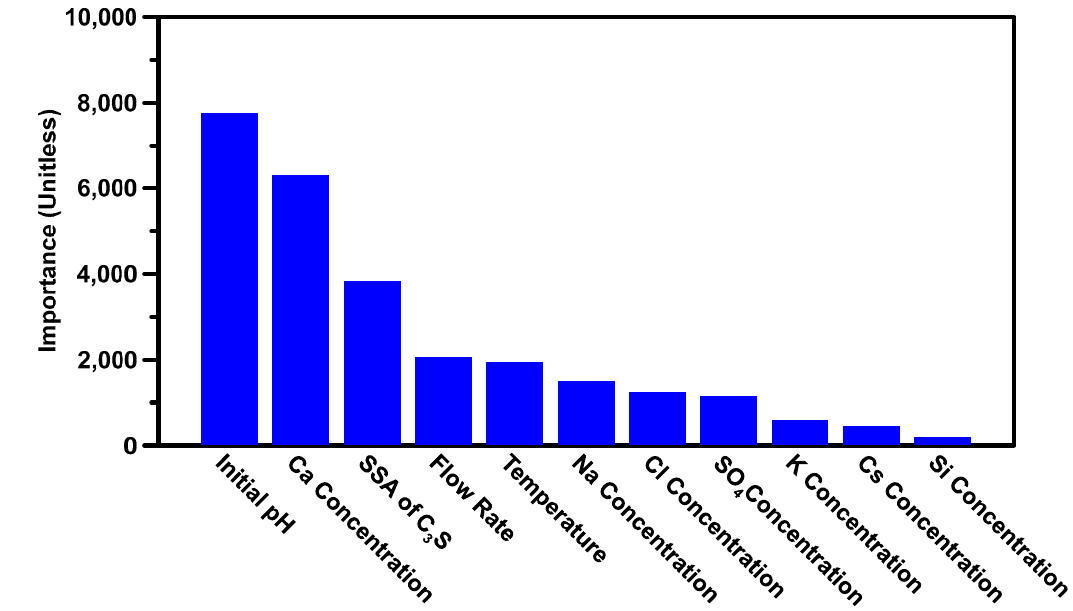
Figure 2. The influence (importance) of input variables based on their contributions towards the C 3 S dissolution rate. The permutation of the rank is shown in a descending manner, where variables on the left side have more influence.